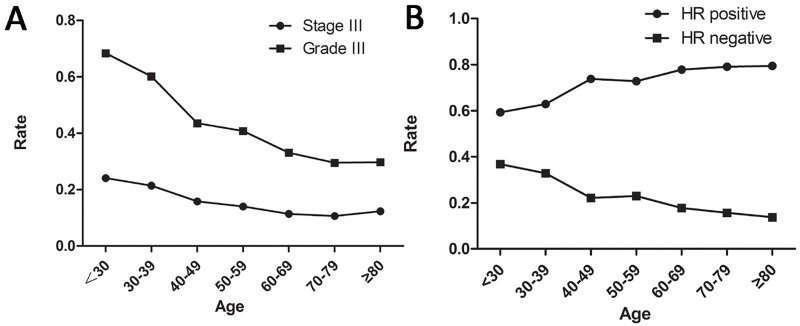
Distributions of grades, TNM stages and hormone receptor (HR) statuses among age groups.A. Distributions of grades and TNM stages. B. Distributions of hormone receptor (HR) statuses.